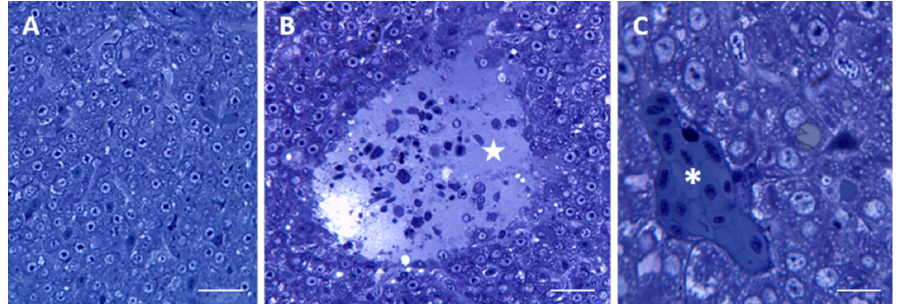
Figure 3. Light micrographs of Danio rerio liver section after 96 h of exposure to 7.7 μ g/L HgCl 2 . ( A ) General appearance of liver morphology after 96 h of exposure to 7.7 μ g/L HgCl 2 . Bar 25 μ m; ( B ) In the liver parenchyma lysed area (star) are visible. Bar 25 μ m; ( C ) The cytoplasm of hepatocyte appears vacuolated. It is possible to see some occluded vessels (asterisks). Bar 10 μ m. All toluidine blue.